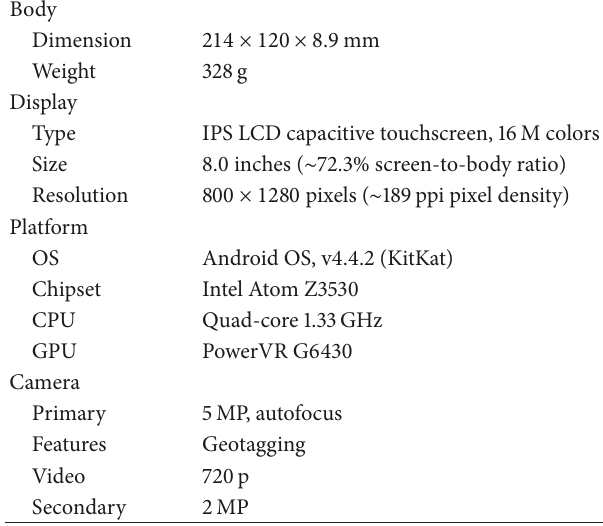
Table 6: Hardware